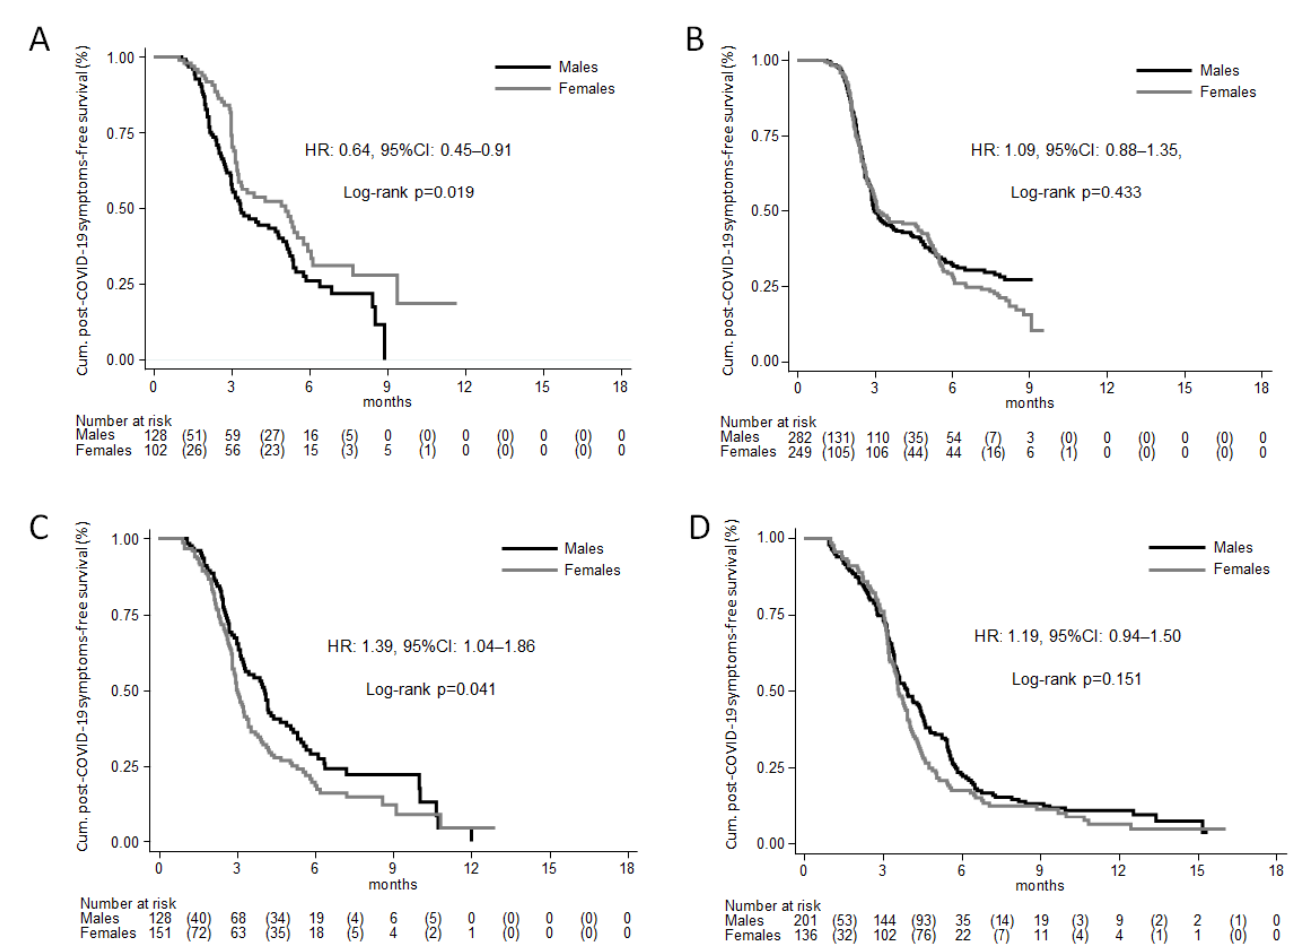
Figure 2. Kaplan-Meier estimates of cumulative reported frequency of post-COVID-19 symptoms, by sex, ( A ) in subjects 0 – 5 years of age, ( B ) 6 – 11 years of age, ( C ) 12 – 50 years of age, and ( D ) >50 years of age. The numbers in parentheses represent the number of symptoms that were reported within each time interval, by sex. The estimate of the hazard ratio (HR) was based on a Cox proportional hazards regression model, adjusted for age.